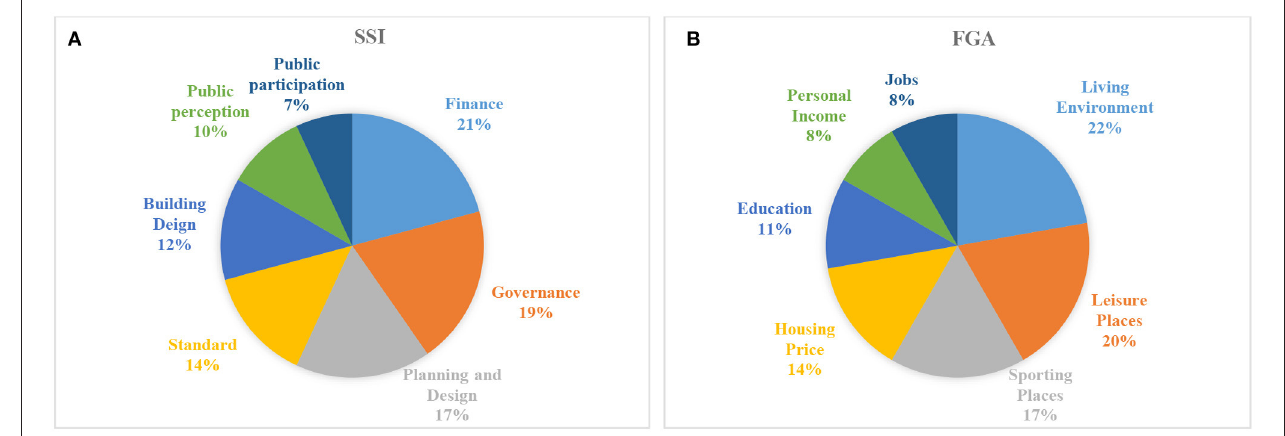
FIGURE 4 | The occurrence ratio of key topics in SSI (A) ; the occurrence ratio of key topics in FGA (B)